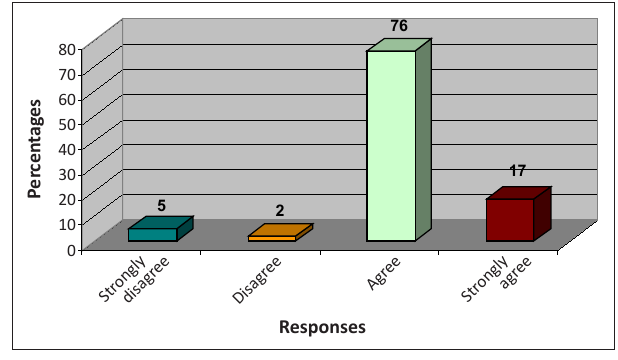
FIGURE 2: Respondents’ views on the importance of providing health education to school children about tuberculosis prevention ( n = 59).